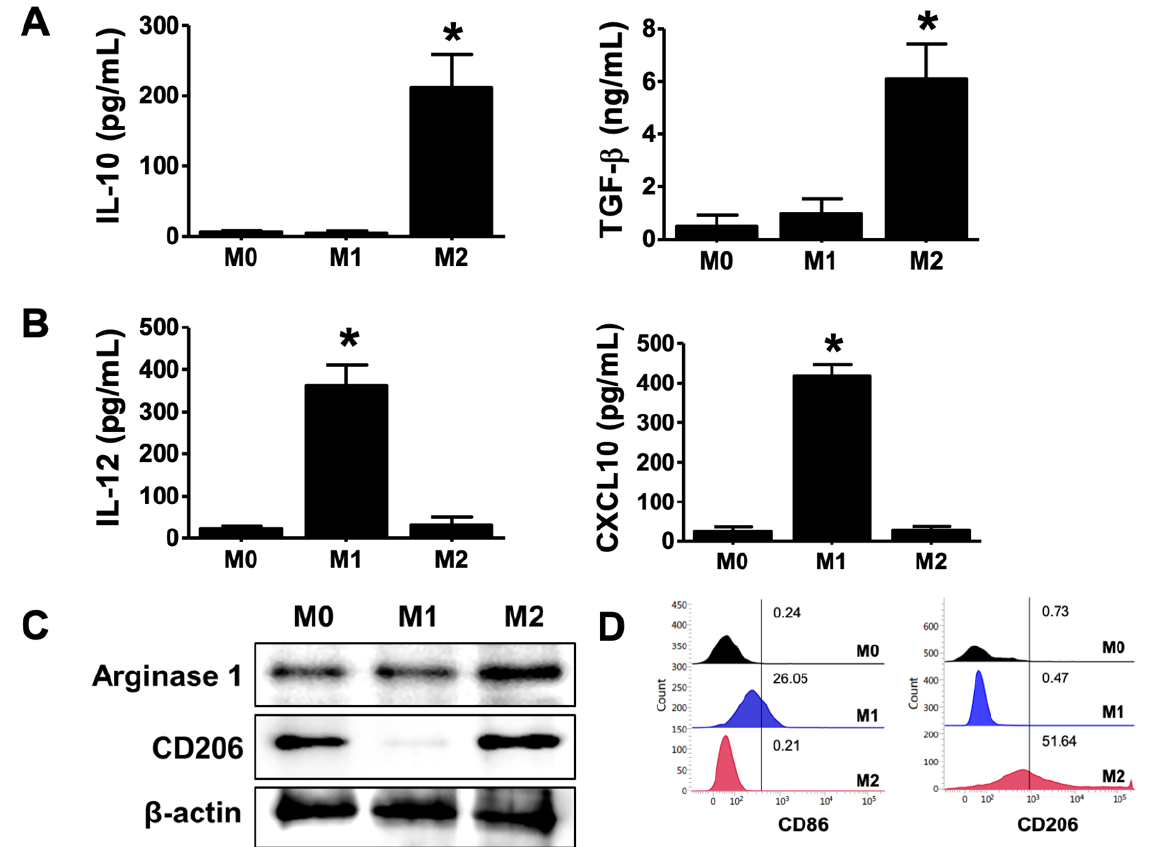
Figure 1. Differentiation of M2 phenotype in THP-1-derived macrophages. Human monocytes (THP-1) were treated with 100 nM PMA for 24 h and cultured with the following: 100 ng/mL LPS and 20 ng/mL rhIFN- γ for M1 macrophage differentiation ; 20 ng/mL rhIL-4 and 20 ng/mL rhIL-13 for M2 macrophage differentiation. ( A ) Production of IL-10 and TGF- β as M2 macrophage markers was measured by ELISA. ( B ) Production of IL-12 and CXCL10 as M1 macrophage markers was measured by ELISA. ( C ) Expression of arginase 1 and CD206 protein was determined by Western blot as M2 macrophage markers. ( D ) Expression of CD86 and CD206 was measured by flow cytom- etry. All data are presented as means ± SD; * p < 0.05 versus the M0.